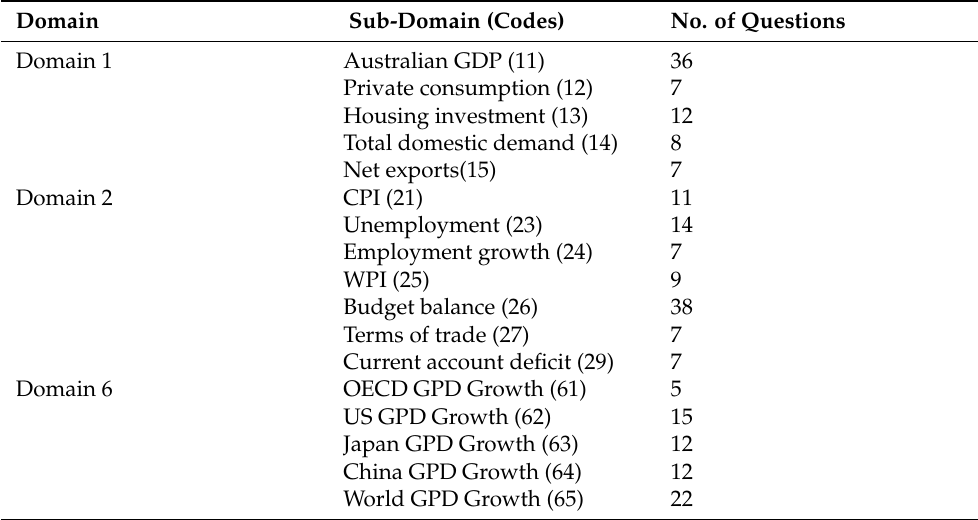
Table 4. The 17 categories (sub-domains) of questions addressed by the experts within three broad